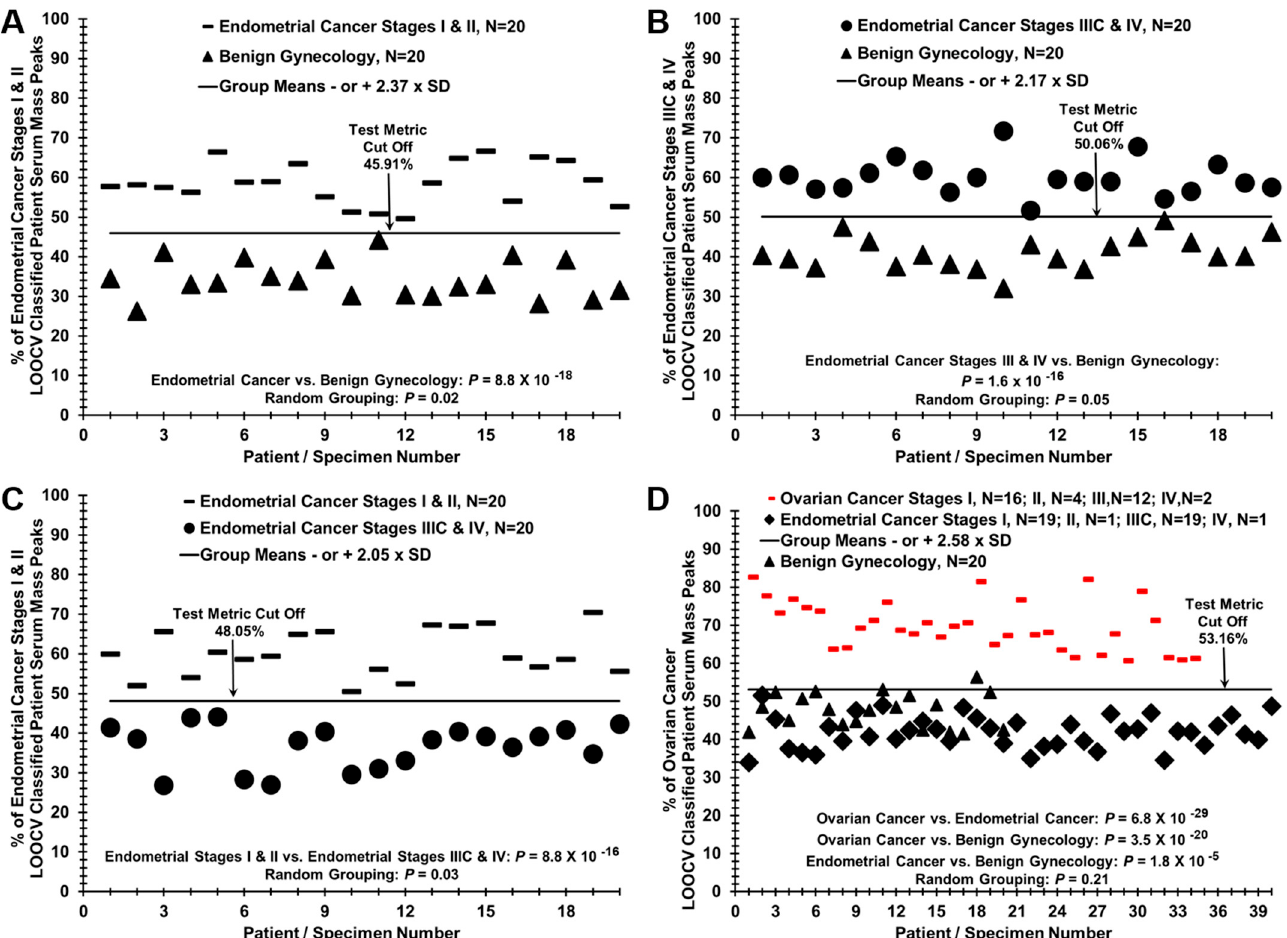
Figure 2. LOOCV analysis comparison of individual groups and ovarian cancer sera. ( A ) Endometrial Cancer Stages I and II compared to Benign; ( B ) Endometrial Cancer Stages IIC and IV compared to Benign; ( C ) Endometrial Cancer Stages I and I compared to Stages IIIC and IV; ( D ) Endometrial Cancer Stages I, II, IIIC and IV endometrial cancer compared to Ovarian Cancer Stages I, II, III and